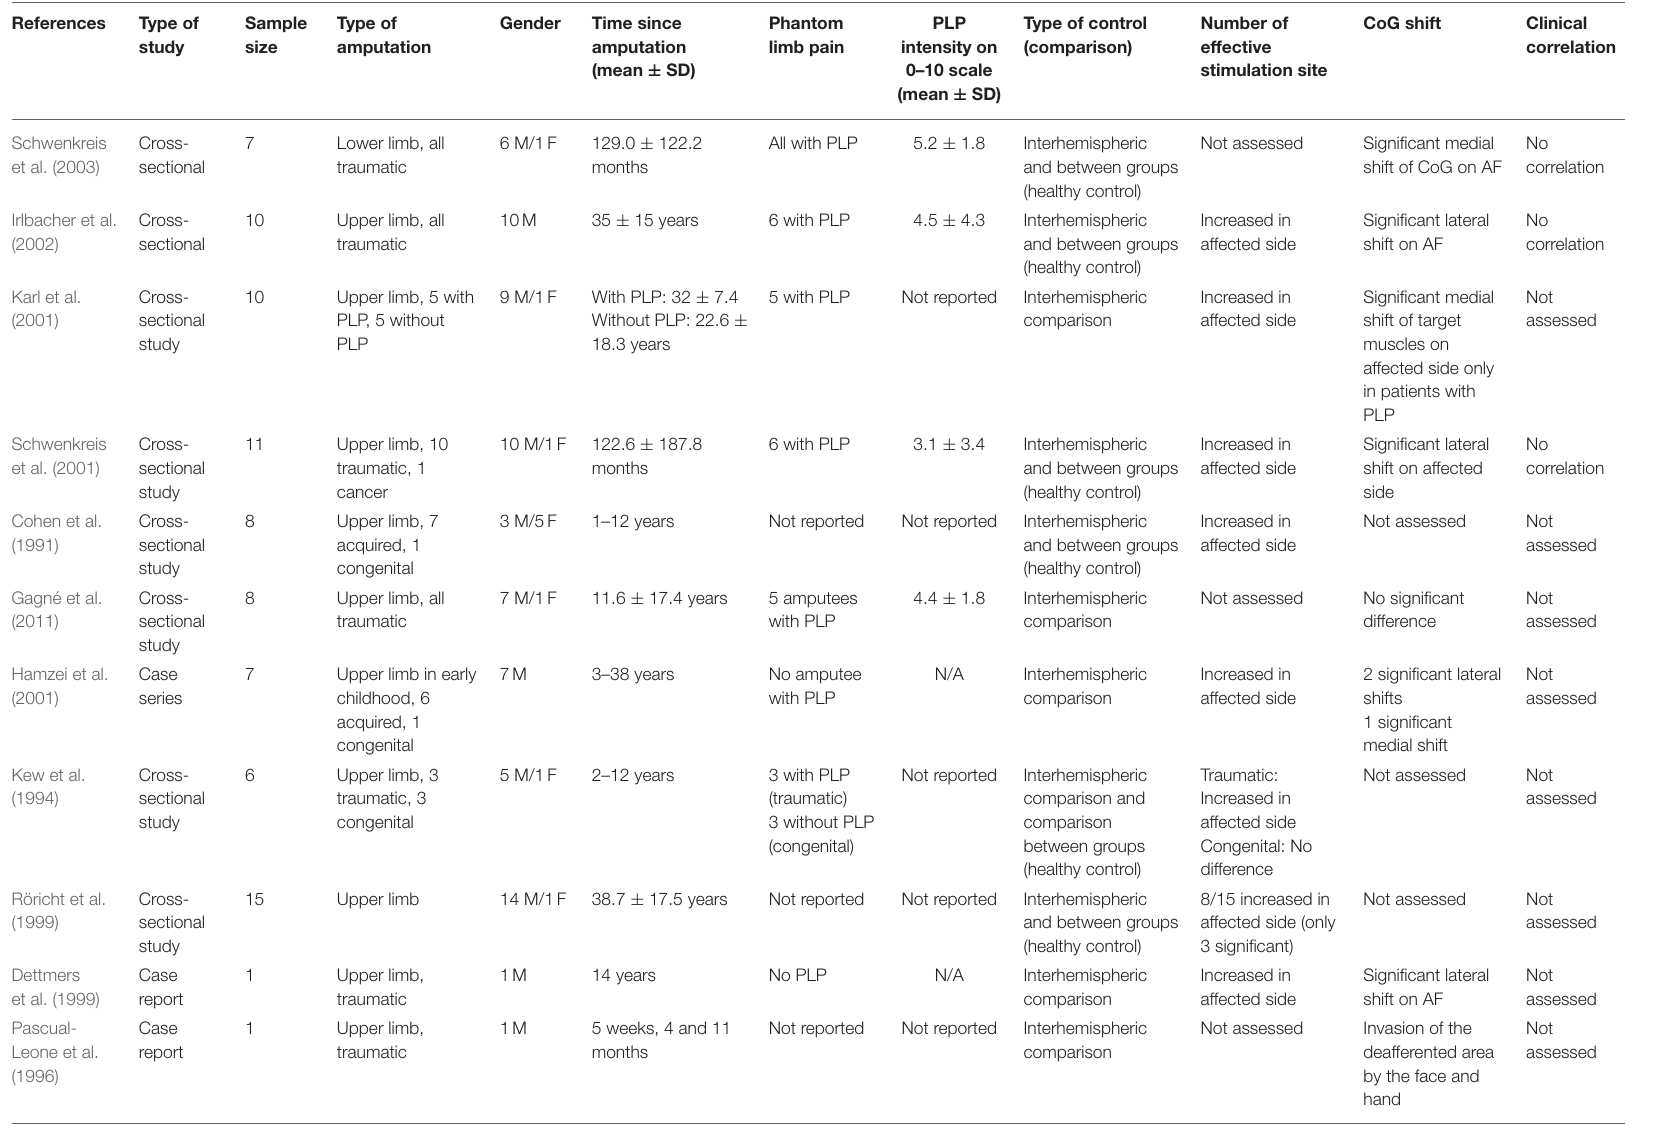
TABLE 1 | Characteristics of included